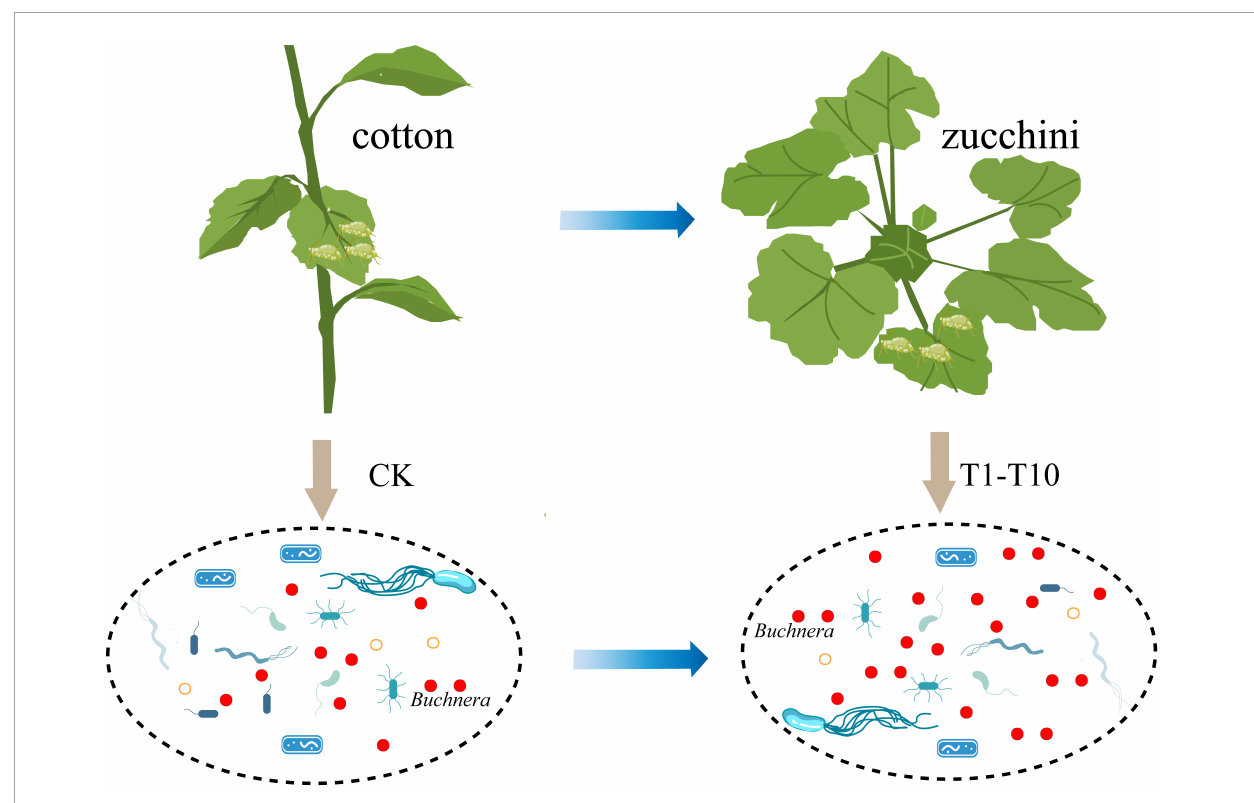
FIGURE4 Pattern of transfer of cotton-specialized aphids from cotton to